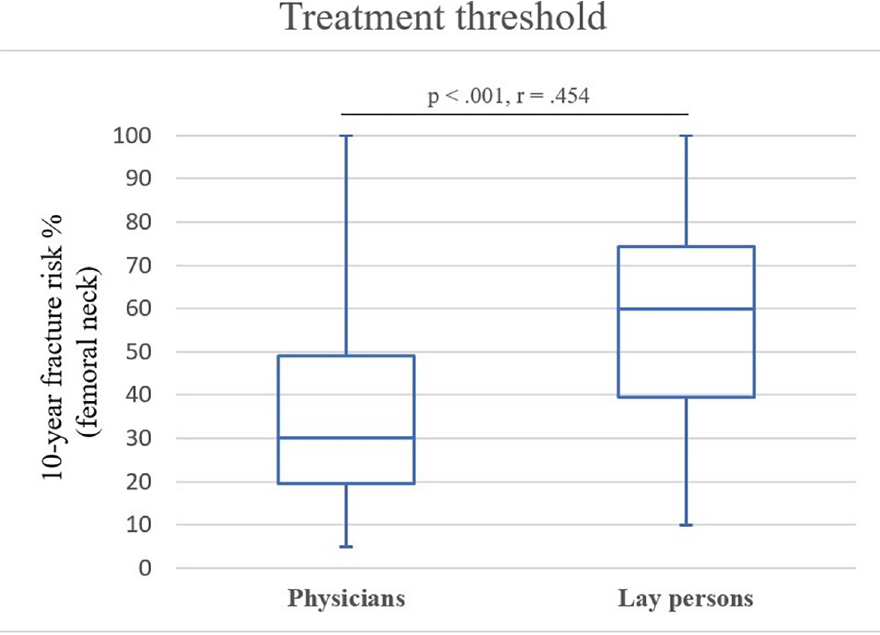
Fig 2. Box plot representation of treatment thresholds of physicians and lay persons. Median, Q1 and Q3 are reported. Whiskers indicate minimum and maximum. Question: “At what individual risk of suffering a femoral neck fracture within 10 years would you prescribe/take